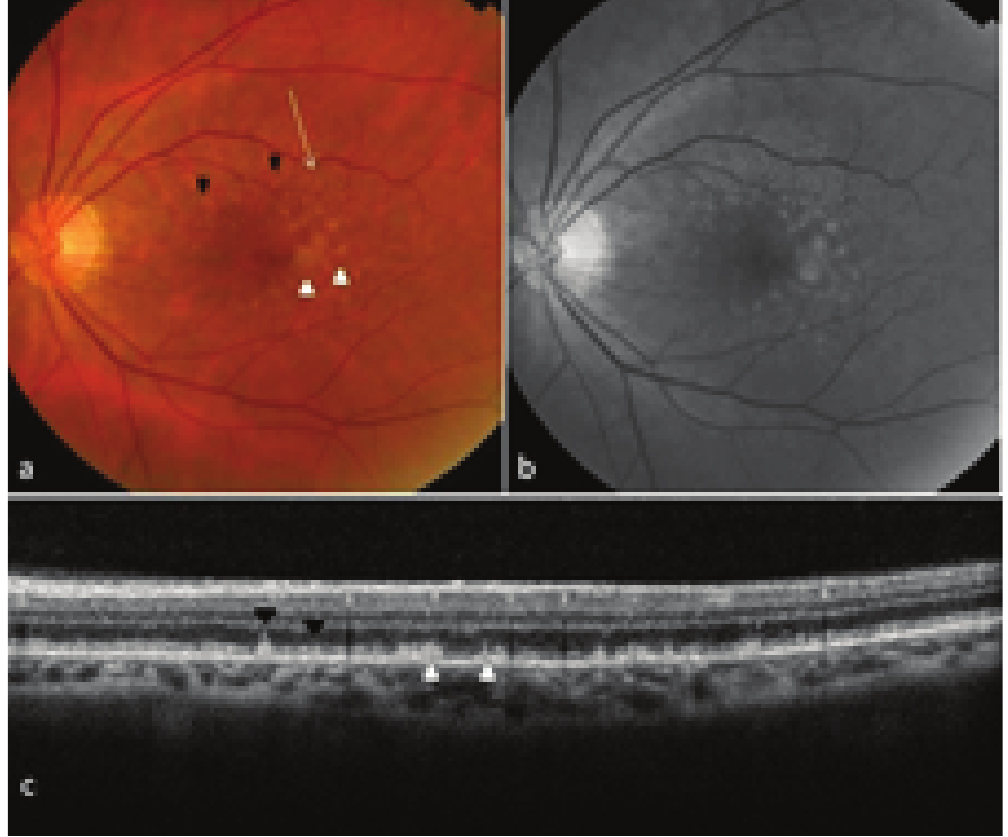
Figure 5. Multimodal imaging of a case of AMD. (a) Fundus photograph shows multiple soft drusen at the fovea (white arrowheads). Numerous dot-like SDD are seen predominantly in the perifoveal area (black arrowheads). (b) The SDD are better delineated than soft drusen on red-free imaging. (c) SD-OCT image through the white arrow in subfigure “a” shows sharp peaked subretinal dot-like SDD (black arrowheads) disrupting the ellipsoid zone and smooth mounds sub-RPE suggestive of soft drusen (white